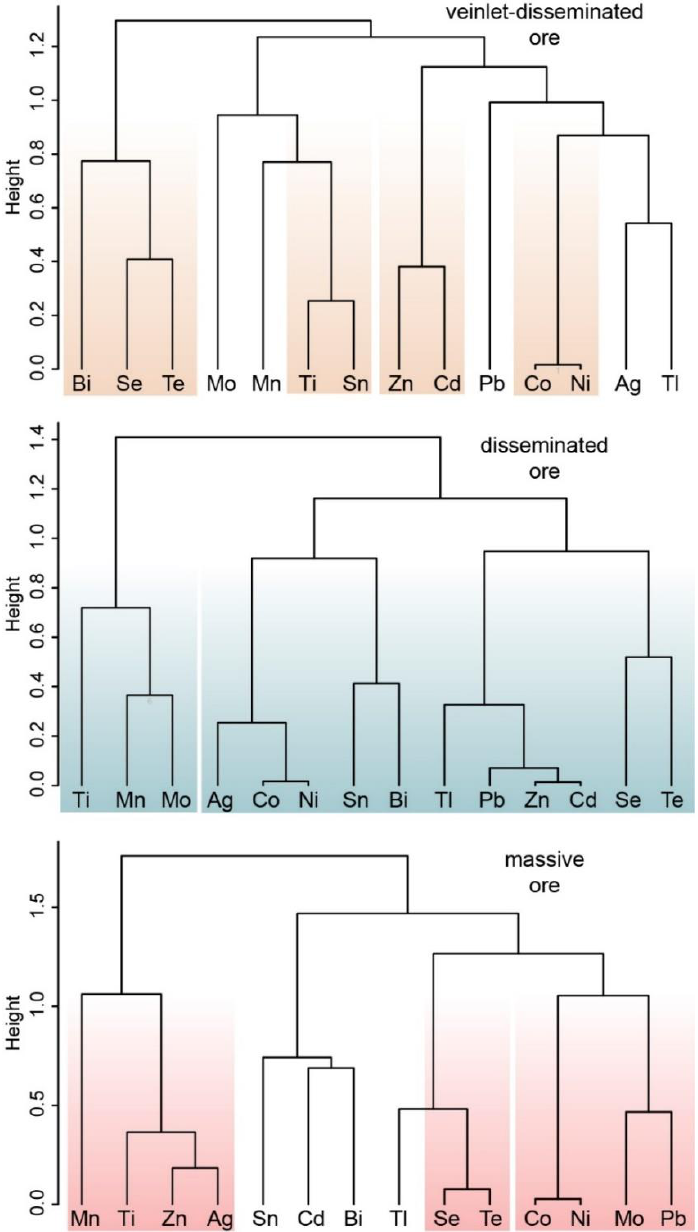
Figure 6. Cluster analysis of trace elements in chalcopyrite of veinlet-disseminated, disseminated and massive ores of the Oktyabrsk deposit. Colors underline elements with high similarity determined by cluster analysis.